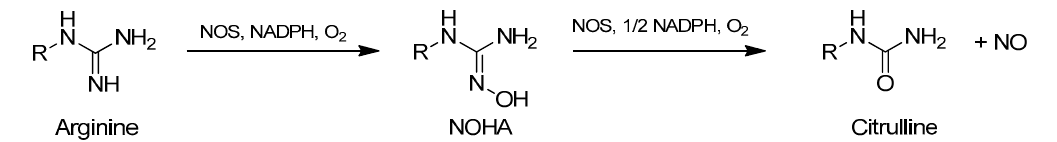
Figure 2. In vivo NO synthesis from arginine.